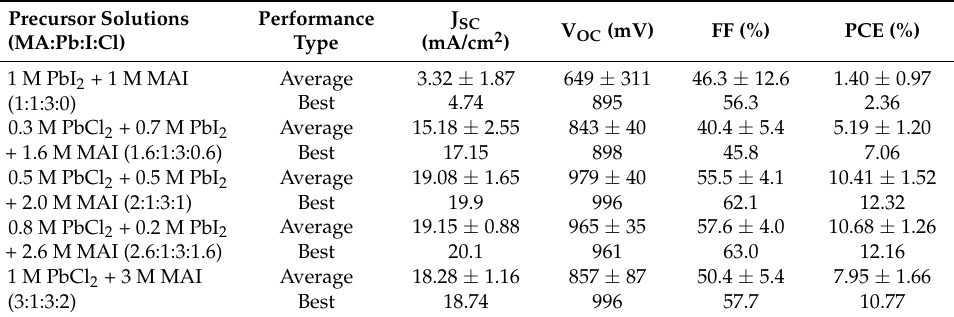
Table 1. Photovoltaic parameters of perovskite solar cells as a function of PbCl 2 concentration